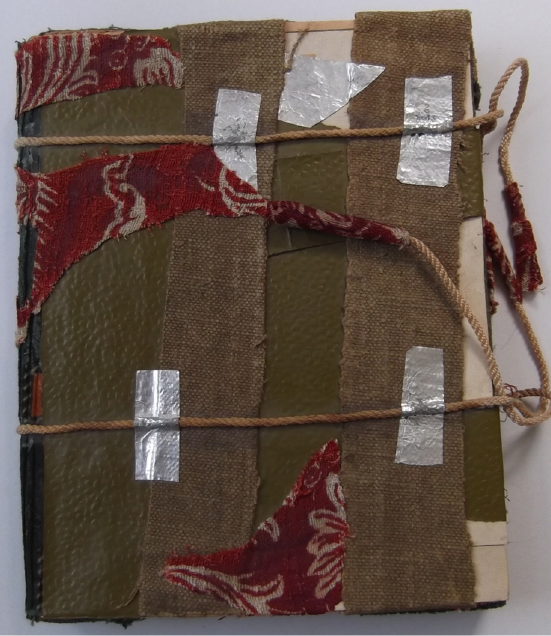
Figure 12. Box with four Kruchenykh booklets.